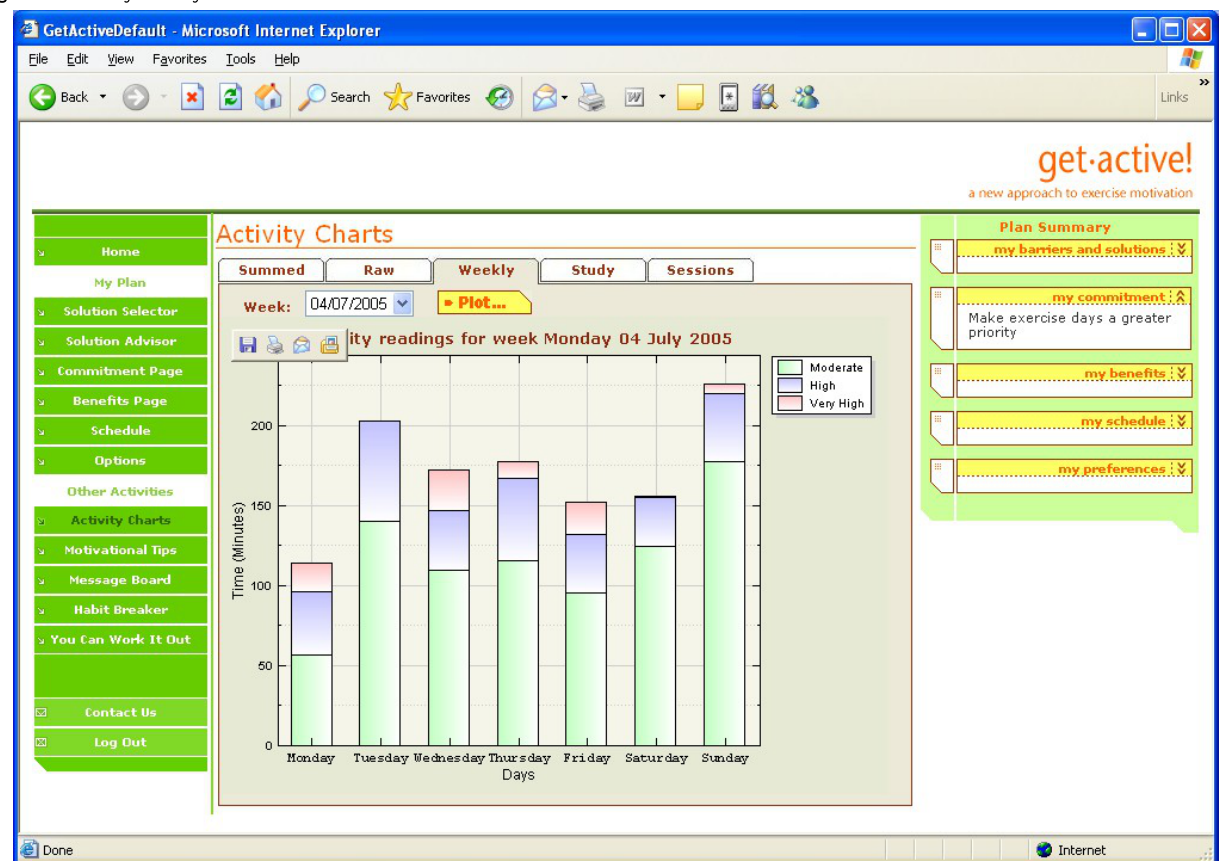
Figure 3. Weekly activity